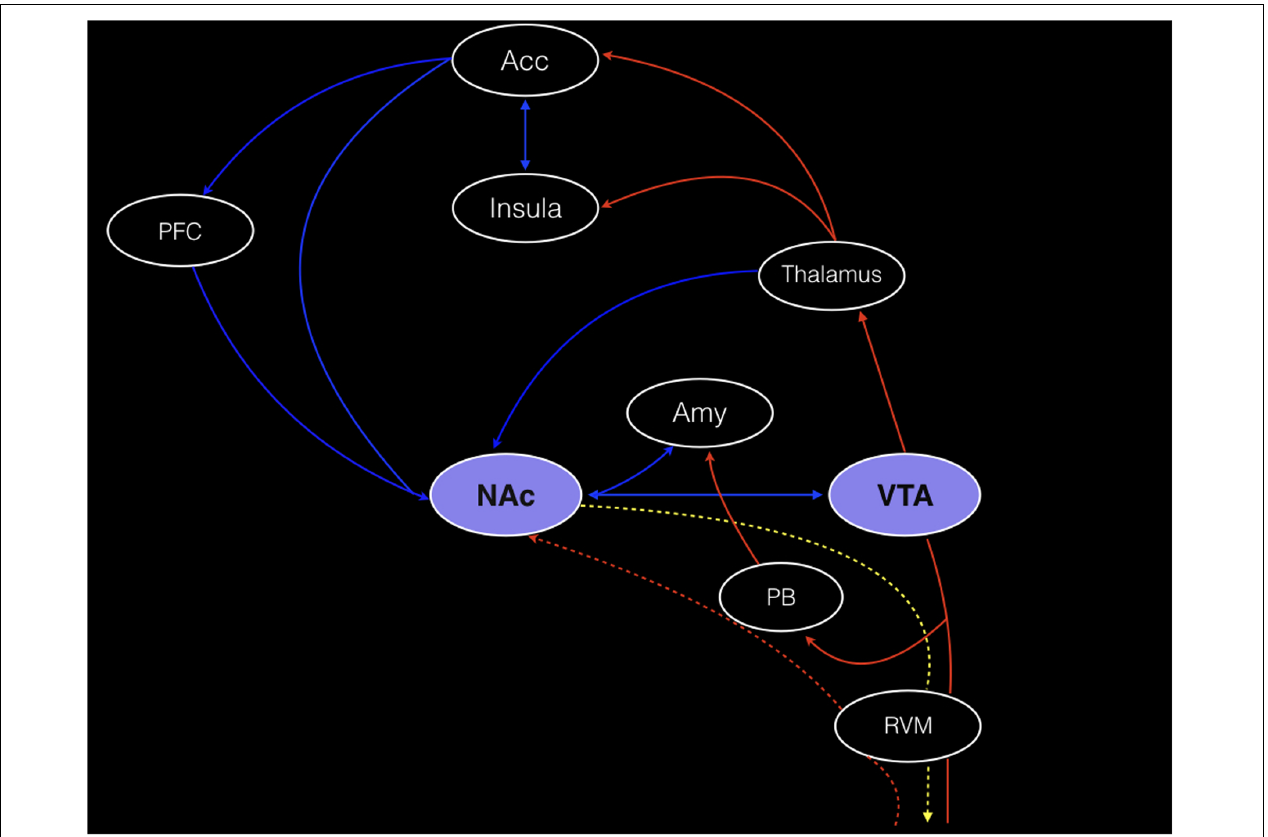
FIGURE 1 | Corticolimbic circuits and the main components of the reward circuitry are illustrated. Red lines: the nucleus accumbens (NAc) receives afferent nociceptive information mainly via connections with the anterior cingulate cortex (ACC), amygdala (Amy), thalamus, and parabrachial nucleus (PB). Possible direct connections from the spinal cord to the NAc (red dotted line) are also shown. Blue lines: corticostriatal projections arising from the prefrontal cortex (PFC) and ACC. The connections between the Amy, thalamus and ventral tegmental area (VTA) and the NAc are also represented by blue lines. The descending pathway from